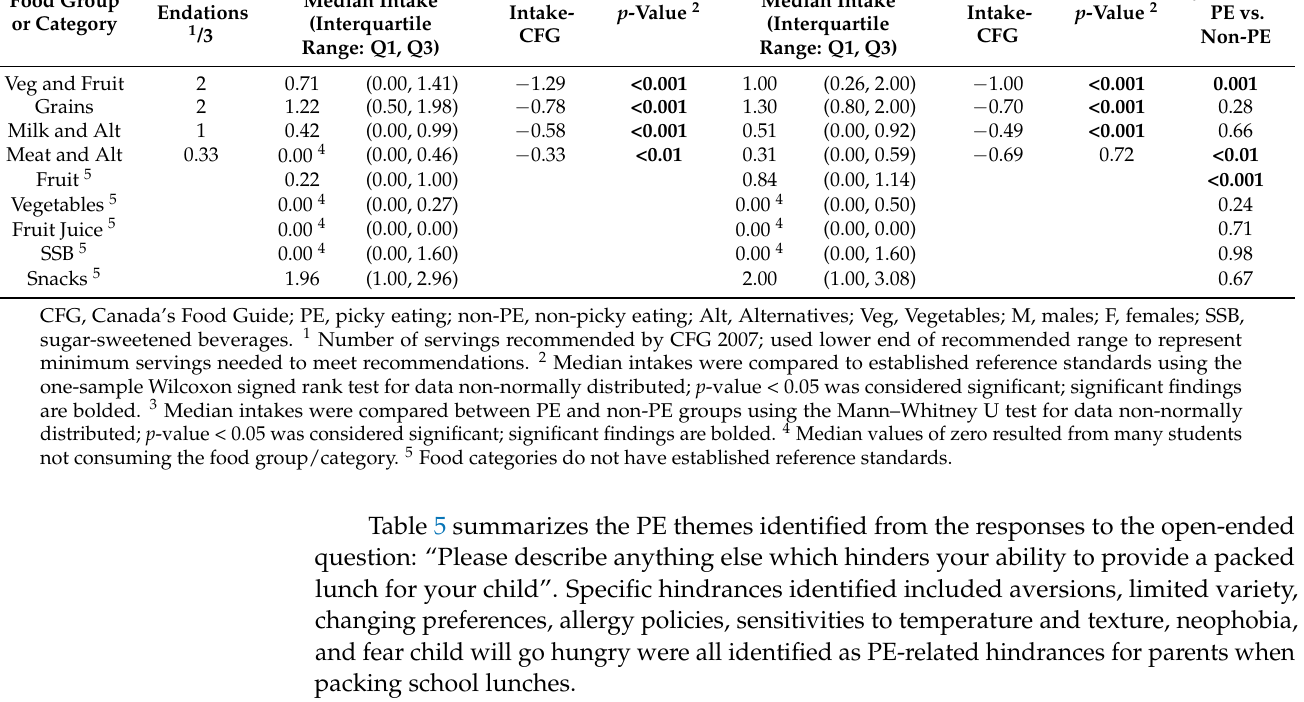
Table 4. Food group consumption from home-packed school lunches by PE status compared to CFG 2007 recommendations. Food Group or Category